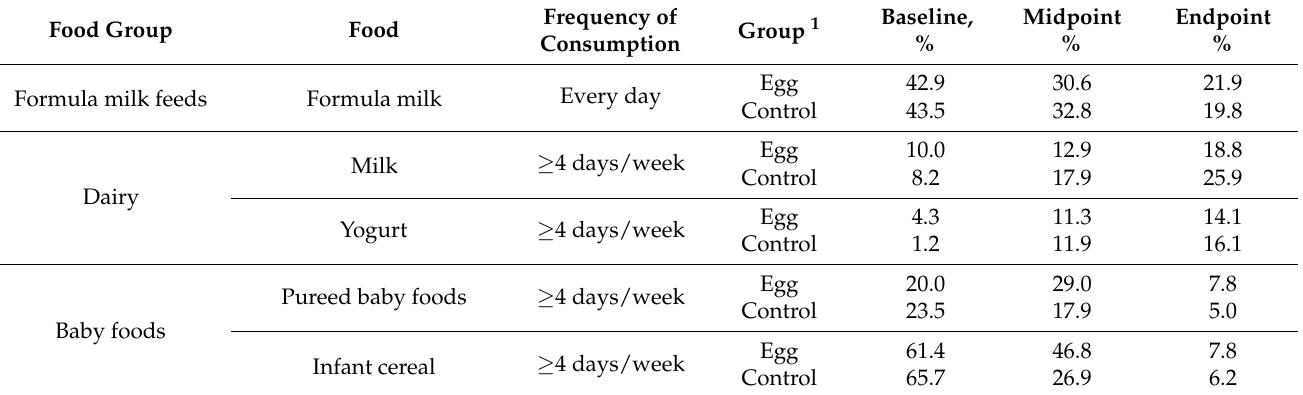
Table 5. Foods consumed during the week preceding baseline, midpoint and endpoint, expressed as a percentage of babies for whom the food frequency questionnaire was